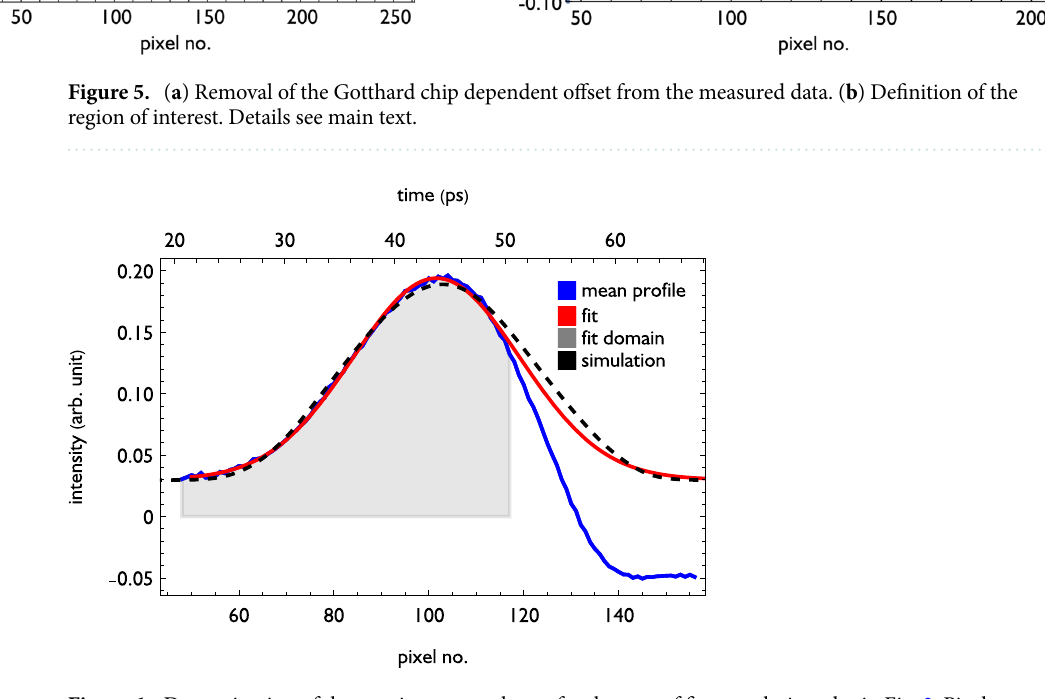
Figure 6. Determination of the rotation center shown for the case of first revolution plot in Fig. 3. Pixel no. 102 is located closest to the center point. The black dashed line displays the mean bunch profile from our simulations. The time axis shown for the experimental data is calculated from calibration measurements 39